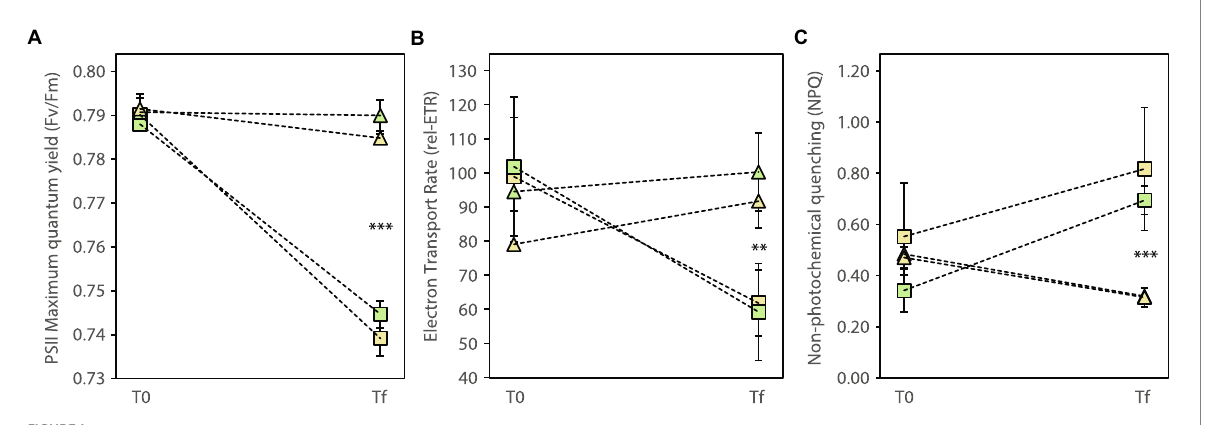
FIGURE 1 Evolution of chlorophyll a fluorescence parameters. (A) Maximum quantum yield of PSII (F v /F m ), (B) electron transport rate (rel-ETR), (C) non- photochemical quenching (NPQ) at the beginning (T0) and end (Tf) of the experiment (±SE, n = 3). Colors indicate absence (yellow) or presence (green) of the interaction with lucinid clams. Symbols are used to indicate control (quadrats) or polluted (triangles) sediment. Asterisks indicate significant differences in the factor “Sediment” at Tf (** p < 0.01; *** p < 0,001); see Supplementary Table S4 for the